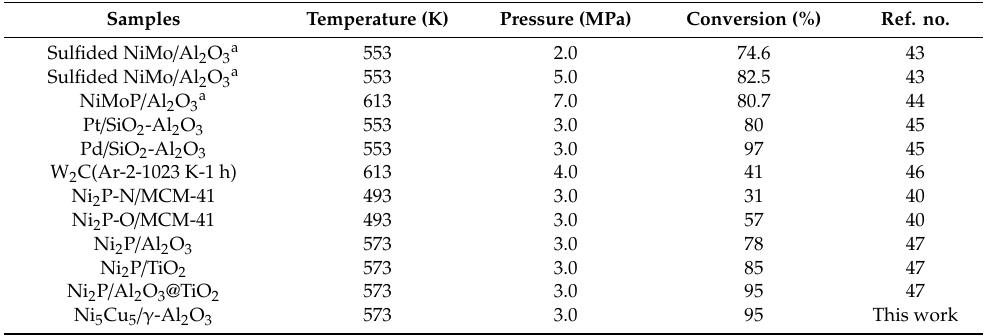
Table 2. Comparison of the typical results of BF HDO from literatures with our present results.